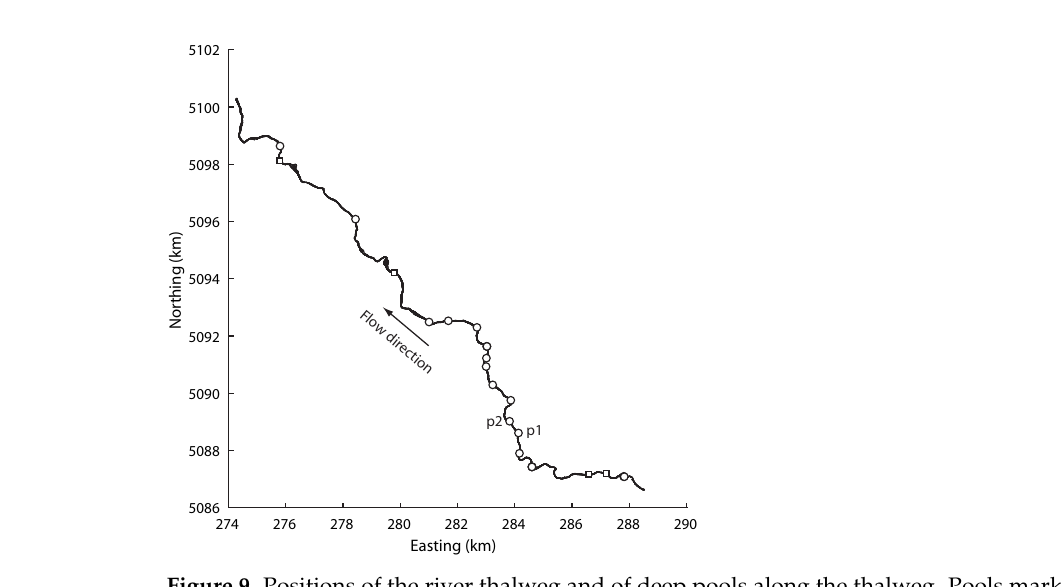
Figure 9. Positions of the river thalweg and of deep pools along the thalweg. Pools marked by an open circle have a maximum underwater depth of d > 5 m, and pools marked by an open square have a maximum depth of 4.5 < d < 5